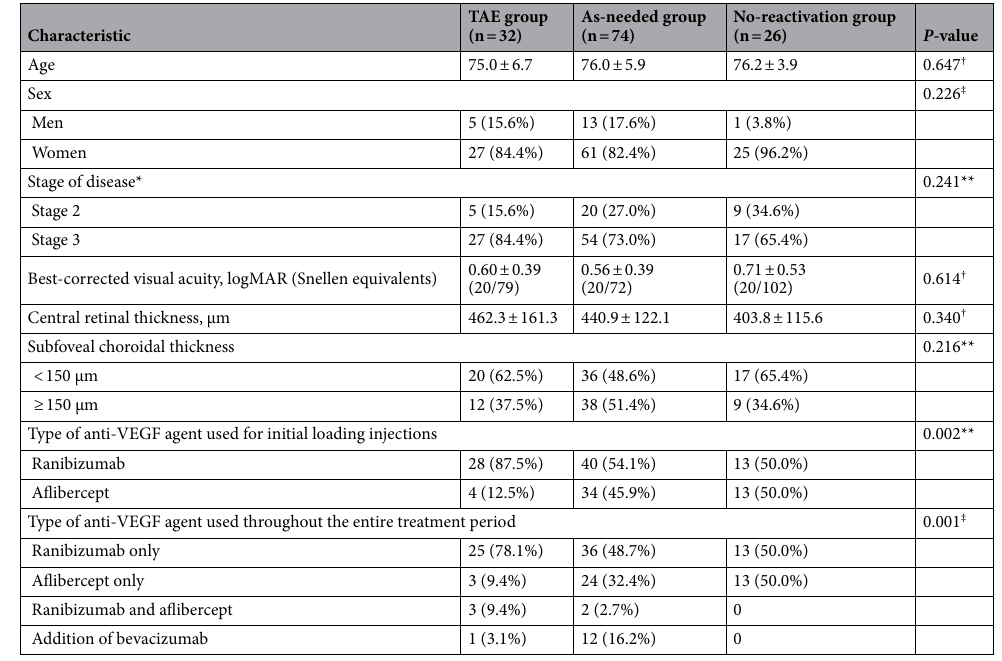
Table 2. Comparison of baseline characteristics among the TAE, as-needed, and no-reactivation groups. Data are presented as mean ± standard deviation or number (%), where applicable. logMAR logarithm of minimal angle of resolution; TAE treat-and-extend; VEGF vascular endothelial growth factor. † Statistical analysis with the Kruskal–Wallis test. ‡ Statistical analysis with the Fisher’s exact test. * Disease stage was classified based on the method proposed by Su et al. ** Statistical analysis with the chi-square